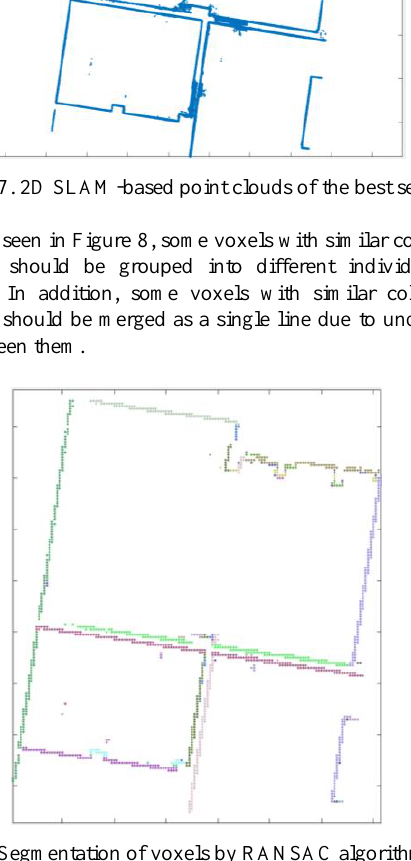
Figure 8. Segmentation of voxels by RANSAC algorithm. Each recognized line has a different color.